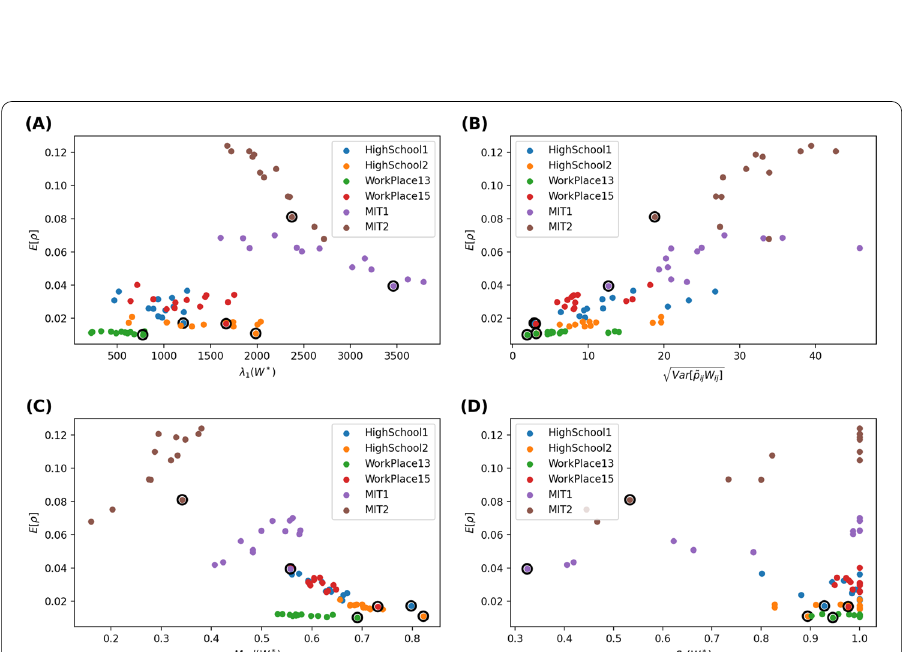
Fig. 5 Scatter plot of the average prevalence E [ ρ ] versus the largest eigenvalue (cid:31) 1 ( W ∗ ) of the aggregated pruned network ( A ), the standard deviation (cid:31) Var [˜ p ij w ij ] of the average number of contacts removed from a node pair ( B ) the modularity Mod ( W ∗ ) ( C ) and the relative size of the largest connected component of the aggregated pruned network ( D ), respectively. A fraction φ = 30% of the contacts are removed. The recovery rate is γ = 1.22 ∗ 10 − 6 per step, approximately 10% per day. The results obtained with 1/link weight strategy are